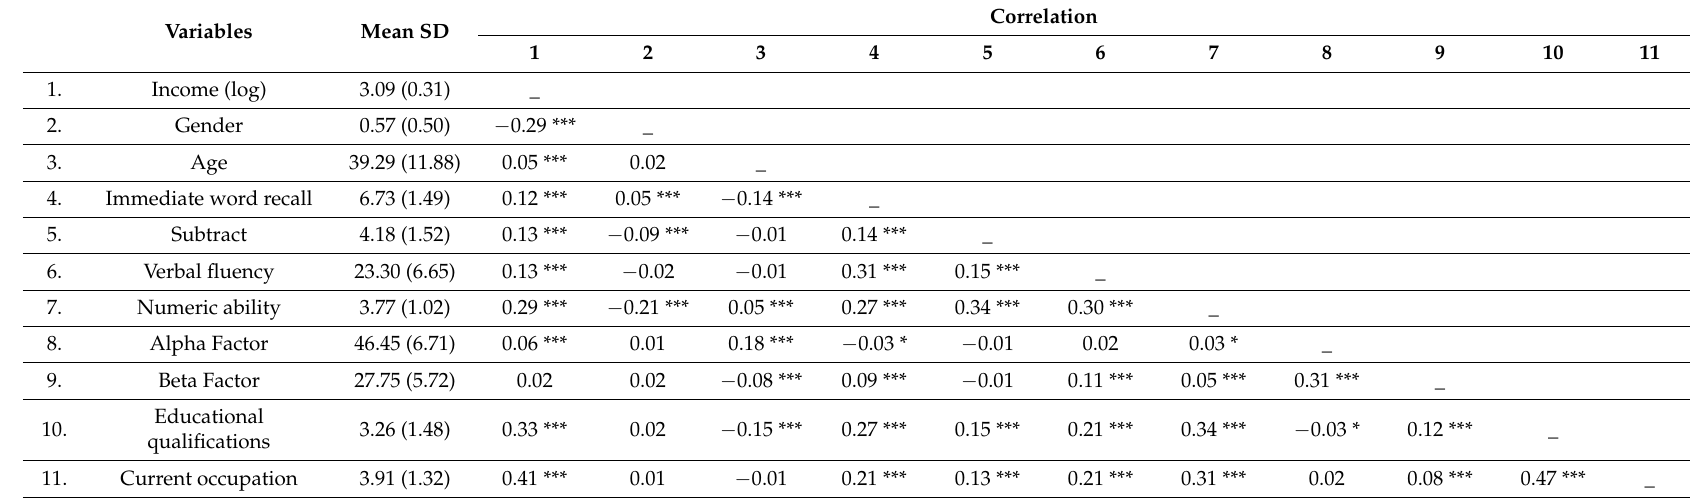
Table 1. Pearson correlations matrix between income, a set of cognitive ability tests, personality factors, education, and occupation.